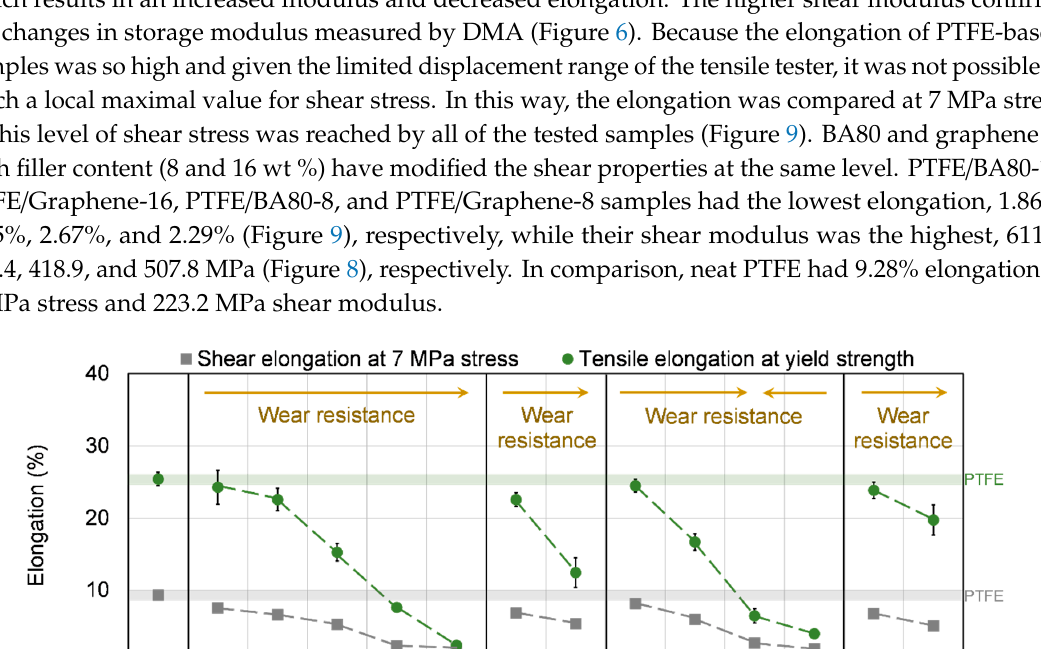
Figure 7. Compressive, shear and tensile stress of unfilled and filled PTFE samples at 5% strain. The blue, grey and green transparent lines display the compressive, shear and tensile stress of neat PTFE, respectively.